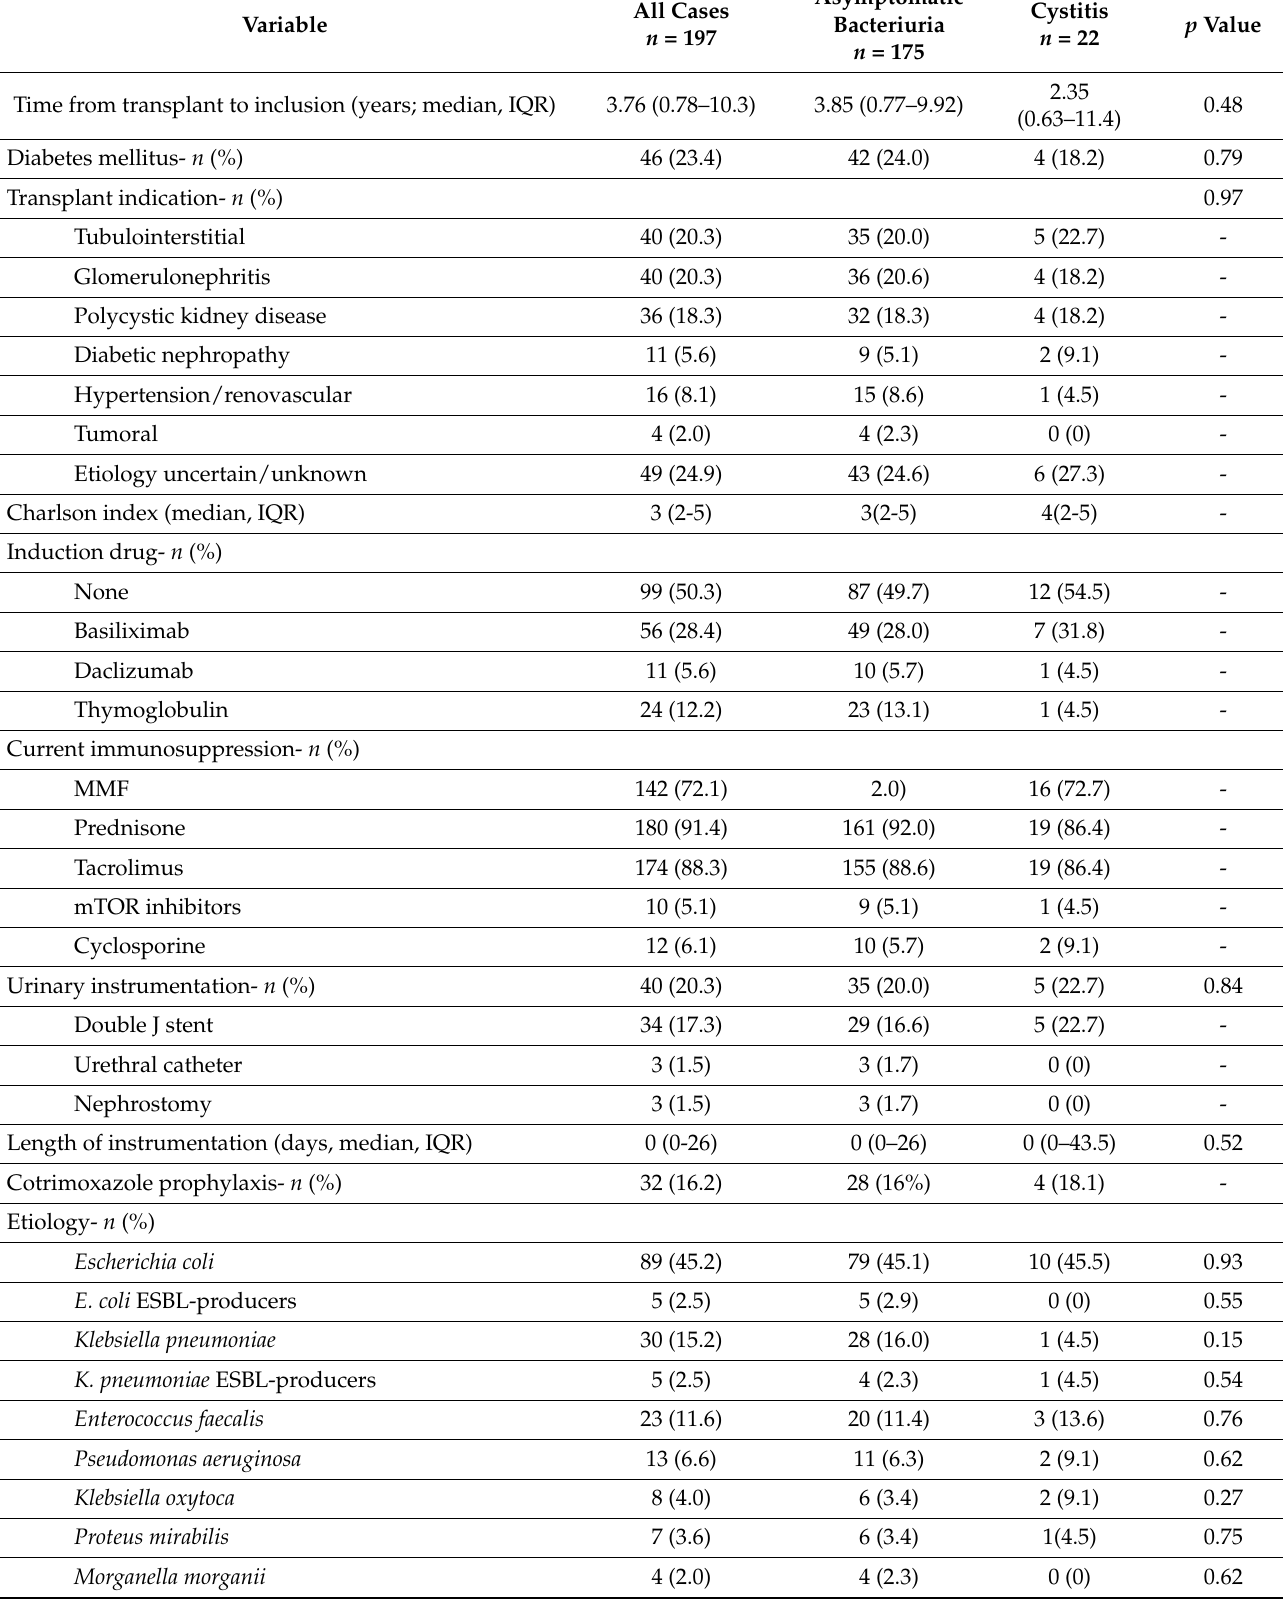
Table 1. Baseline, clinical and microbiological features of kidney recipients with